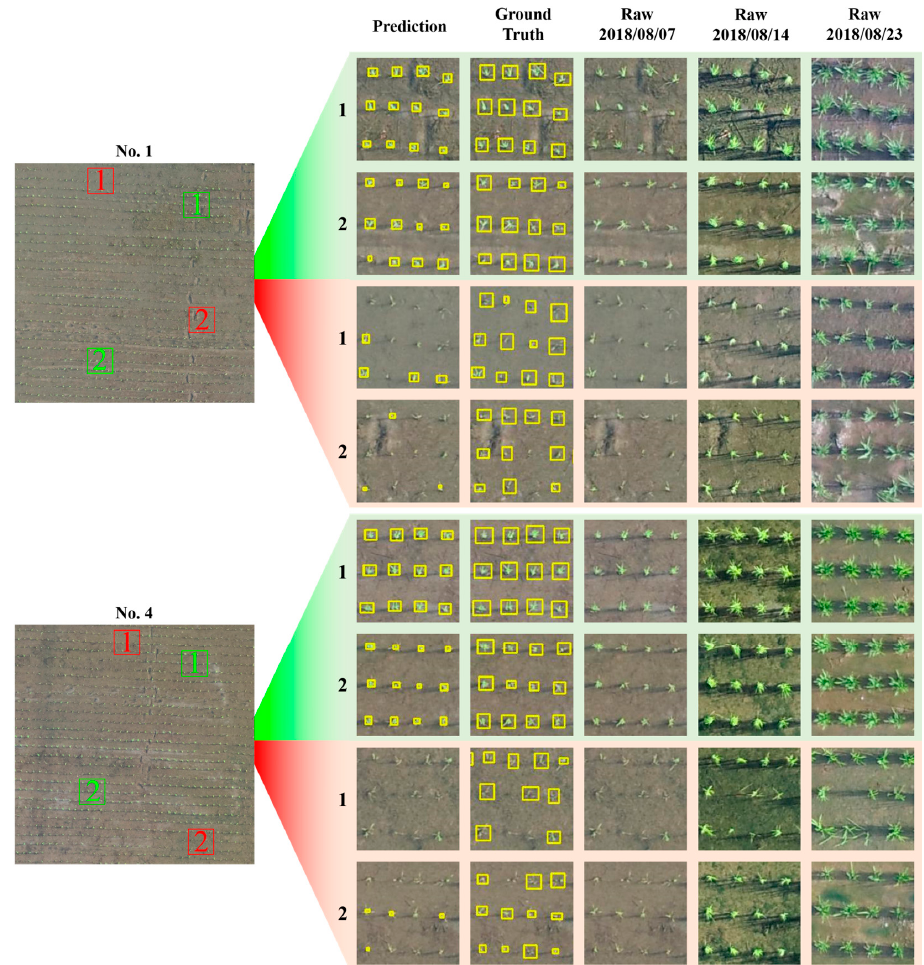
Figure 12. A focused comparison of the detection results between prediction and ground truth images for four subareas in Subset 1 and Subset 4. The images of three sucessive growth stages explain the difference of growing condition. The green areas depict the successful detection, and the red areas depict the worse detection.